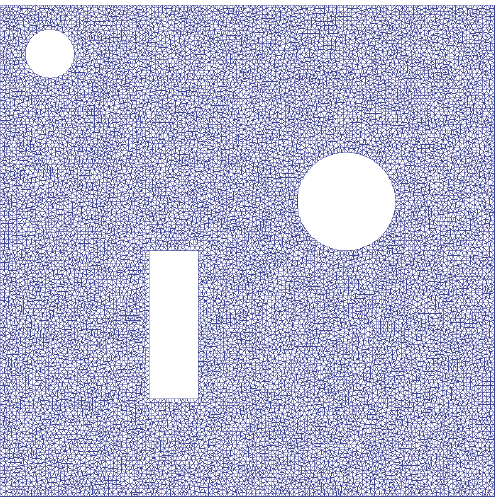
Figure 11: The domain with computational